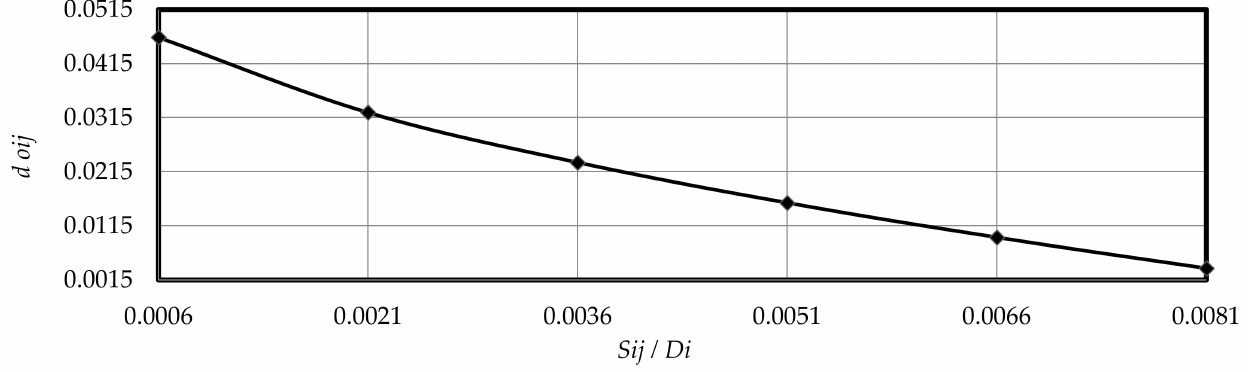
Figure 9. Graph of the change in trip distribution function of employees of the city service enterprises depending on the relation of the cost of travel to the average income of the zone of residence.